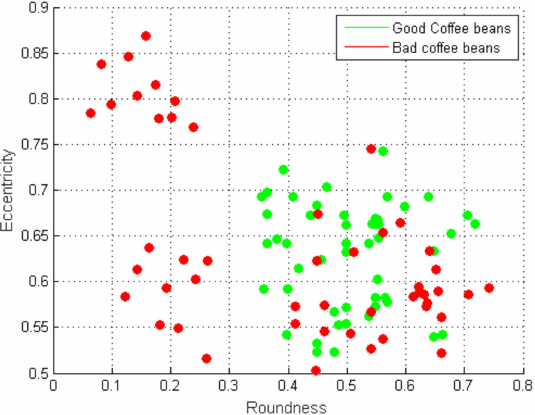
Figure 15. 2D plot of eccentricity and roundness features used for the k -nearest neighbor algorithm using the training